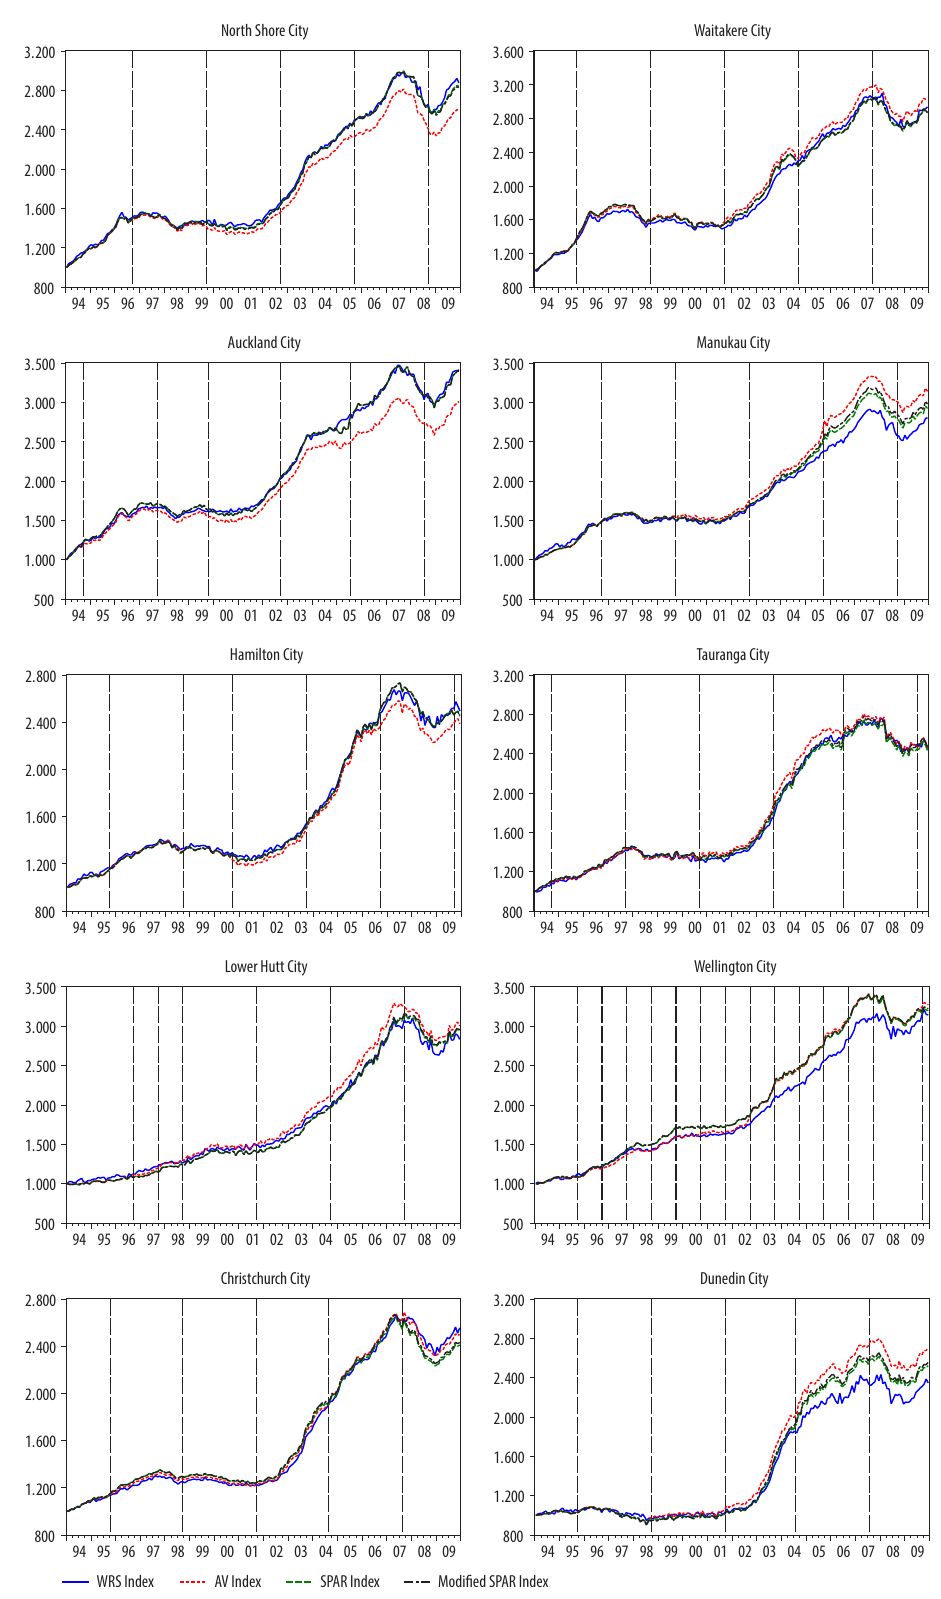
Fig. 2. House price indices for the top 10 cities in New Zealand, Jan. 1994 to Dec. 2009 Notes: The vertical line drawn on the date axis indicates the time of